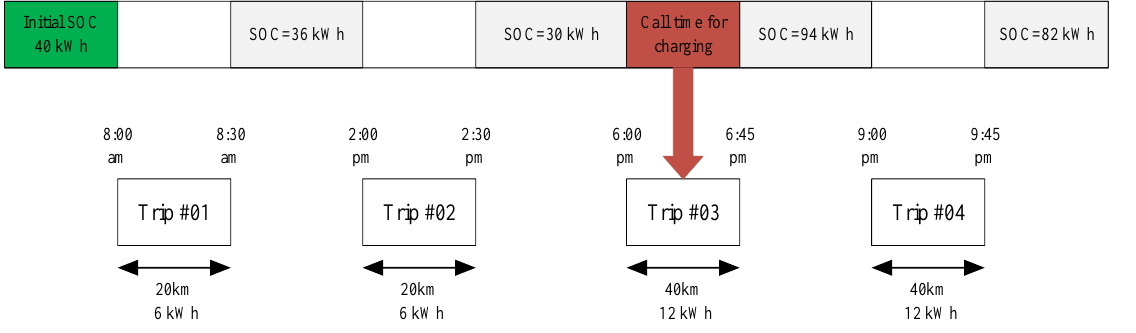
Figure 1. Demonstration of an EV’s calling time for rapid charging or battery-swapping